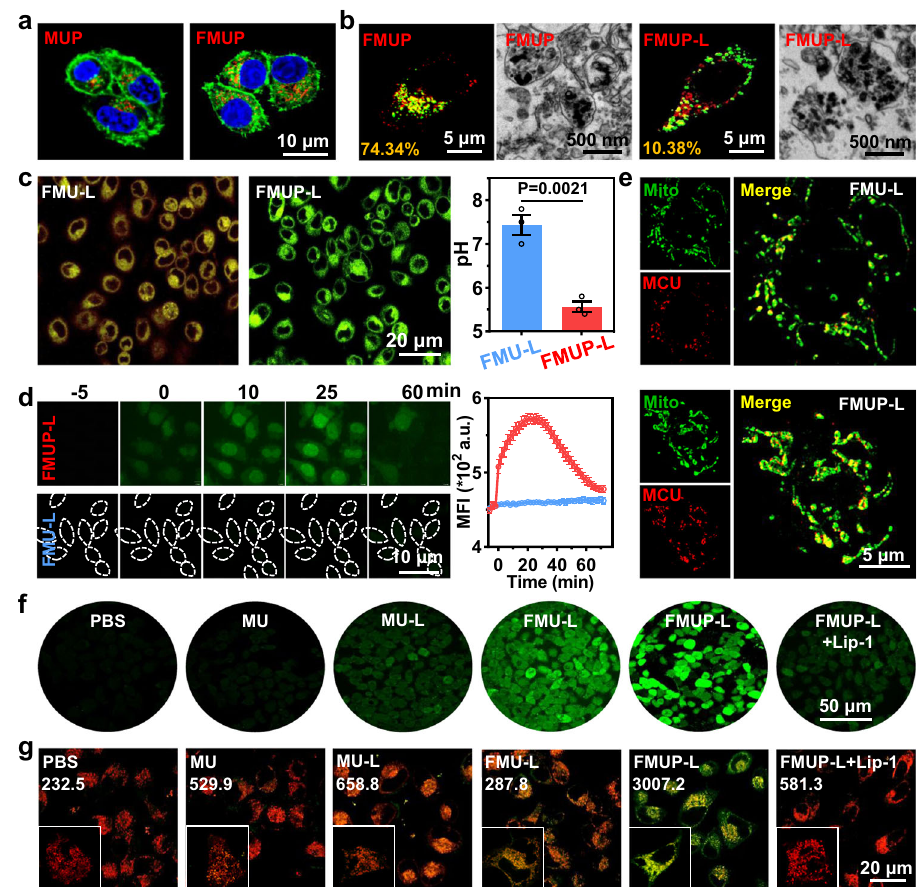
Fig. 3 In vitro assessment of the effect of CDT/acidi fi cation synergism on mitochondria. a CLSM images of MUP and FMUP in HeLa cells. Green: cell membrane; Red: MOFs; Blue: nuclei. b CLSM images and TEM images of lysosomal escape of different treatments (FMU-L and FMUP-L). Green: lysosome; Red: MOFs. The number in the lower left corner represents the co-localization rate. c CLSM images and further quantitative analysis of pH value in different groups (FMU-L and FMUP-L). The greener the cell, the more acidic it is. d CLSM images of calcium in fl ux in group of FMU-L and FMUP-L and corresponding quantitative analysis. Green: Ca 2 + . The outline of dotted line represents the cell. e CLSM images of the expression of mitochondrial calcium uniporter (MCU) in the mitochondria. The higher the expression of MCU, the stronger the calcium overload in mitochondria. Green: mitochondrial; Red: MCU. f Detection of ROS production in HeLa cytoplasm by DCFH-DA with different treatments. Green: ROS. g Detection of lipid peroxidation in HeLa cells by Liper fl uo with different treatments. The statistical value in the fi gure represents the level of lipid peroxidation. Green: lipid peroxidation; Red: mitochondria. Data in ( c ) and ( d ) were represented as mean values ± SD, n = 3 biologically independent samples in ( c ) and ( d ). A representative image of three biologically independent samples from each group is shown in ( a – g ). P value was calculated by the two-tailed Student ’ s t test in ( c